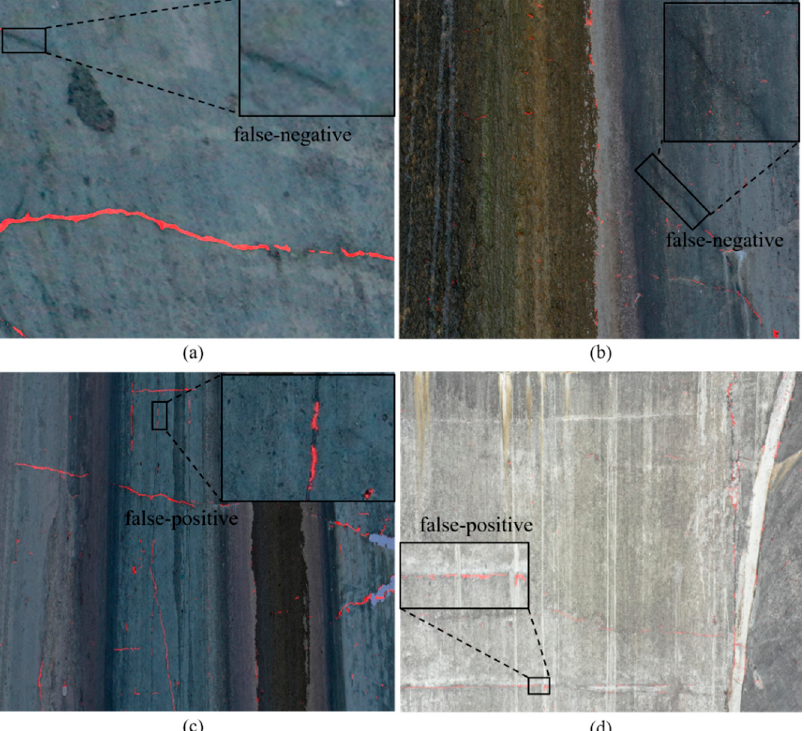
Figure 15. Examples of errors in the test results: ( a ) and ( b ) show false-negative errors; ( c ) and ( d ) show false-positive errors.